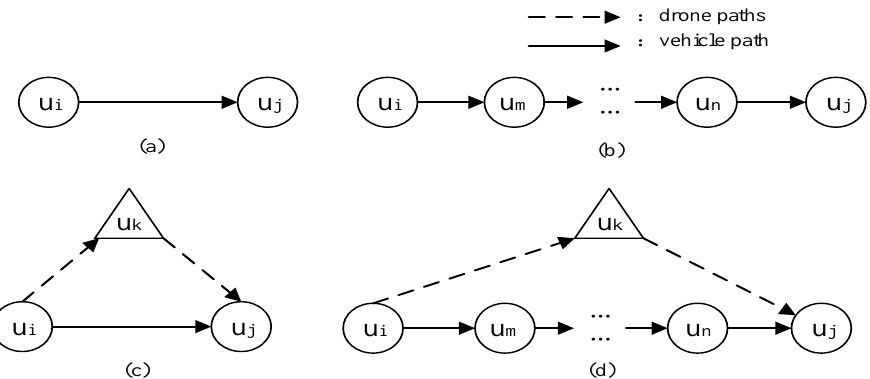
Figure 2. Basic unit for collaborative vehicle and UAV delivery. ( a ) Vehicle distribution path without UAV; ( b ) Continuous vehicle distribution; ( c ) Primary distribution unit path of UAV; ( d ) Vehicle and UAV collaborative distribution.